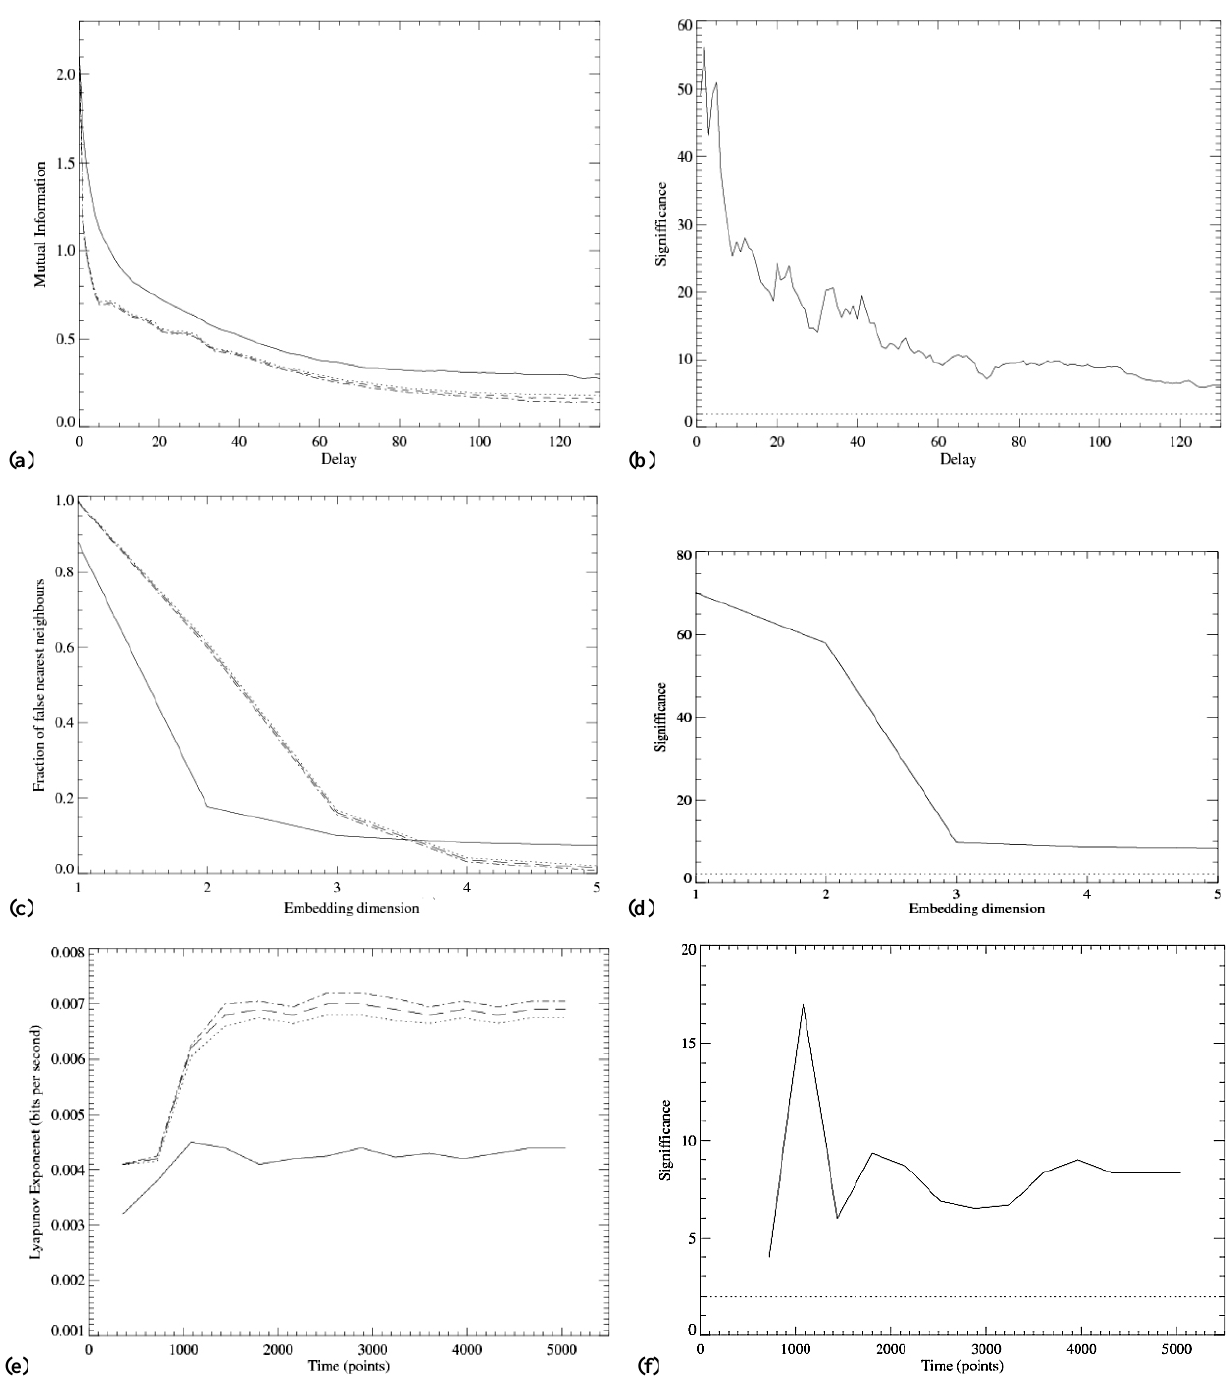
Fig. 5. Plots of (a) mutual information of original data (solid curve) and mean values of the same parameter for surrogates (dashed curve). The sum of the mean value and the standard deviation is represented by the dotted curve, and the difference between the mean value and the standard deviation is represented by the dash-dotted curve. (b) significance of difference represented as a function of delay. Similarly, the comparison of nonlinear characteristics, like fraction of false nearest neighbors (c) , Lyapunov exponent (e) , and local slopes of the correlation sums (g) are presented along with their respective significance of difference ( d, f , and h , respectively) during the period 7–10 June 2005, measured at